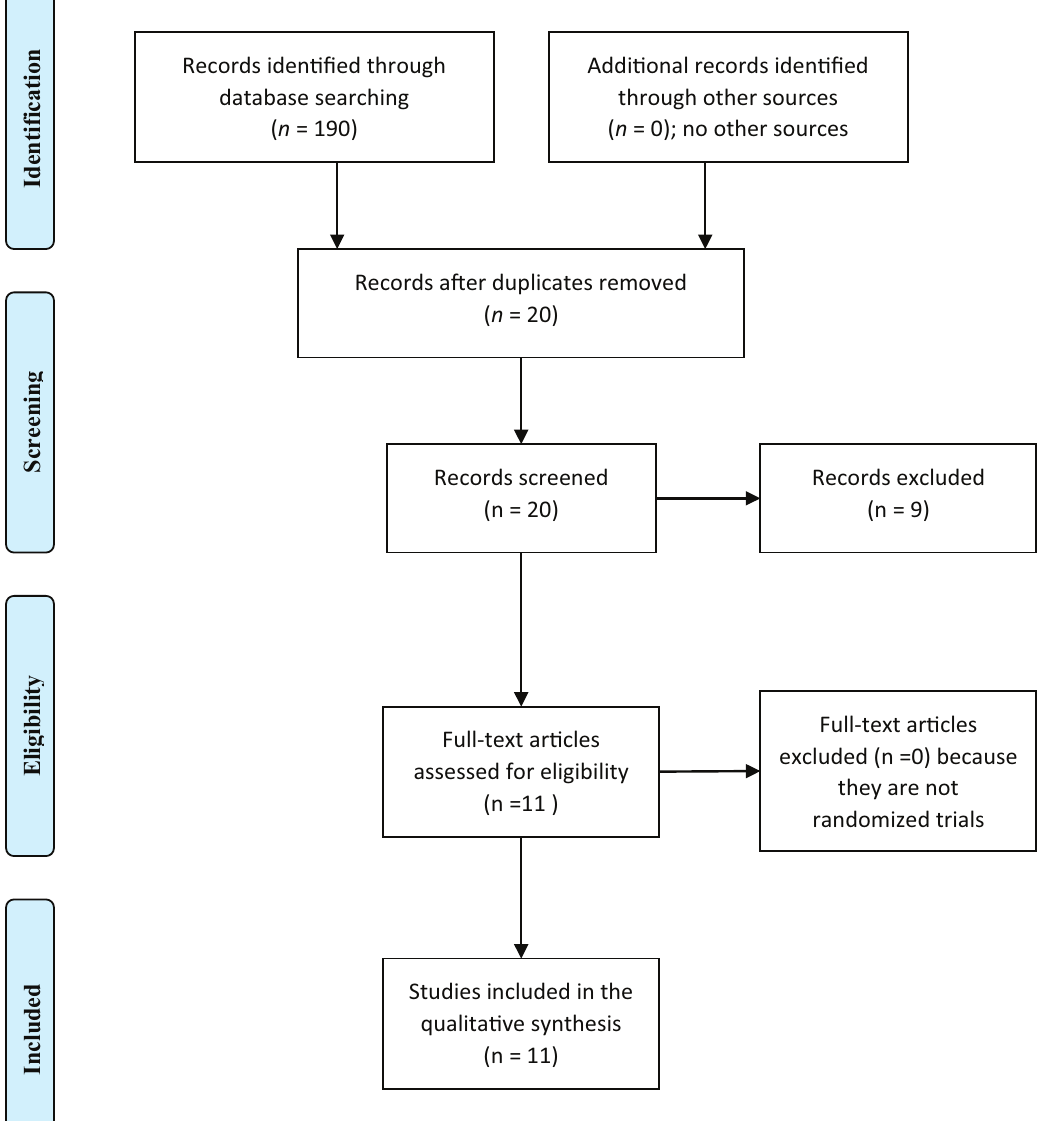
Figure 1: Flow diagram of the different phases of the systematic review (PRISMA